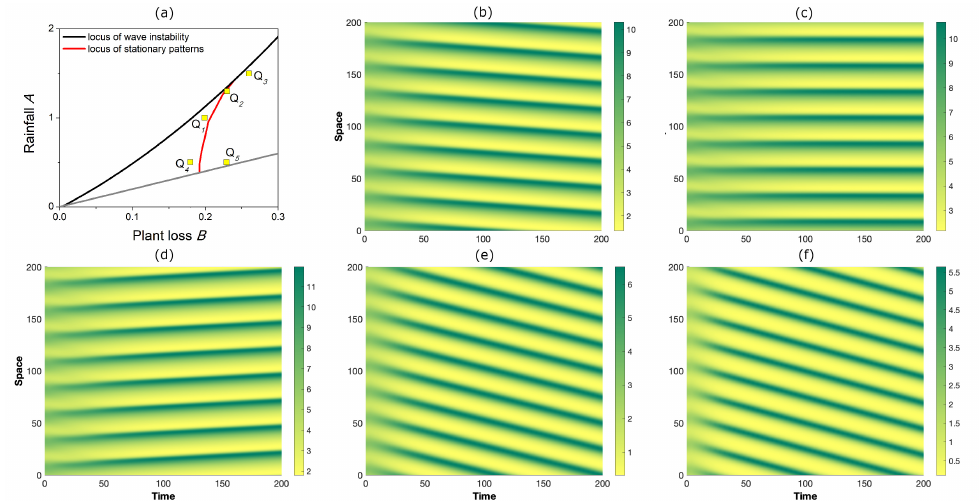
Figure 7. ( a ) Detail of Figure 6d and configurations Q i (i = 1, . . . , 5) in which numerical simulations of system (1)–(3) are performed. Panels ( b – f ) denote the spatio-temporal evolutions obtained in ( b ) Q 1 , ( c ) Q 2 , ( d ) Q 3 , ( e ) Q 4 , and ( f ) Q 5 . Fixed parameter: ψ =